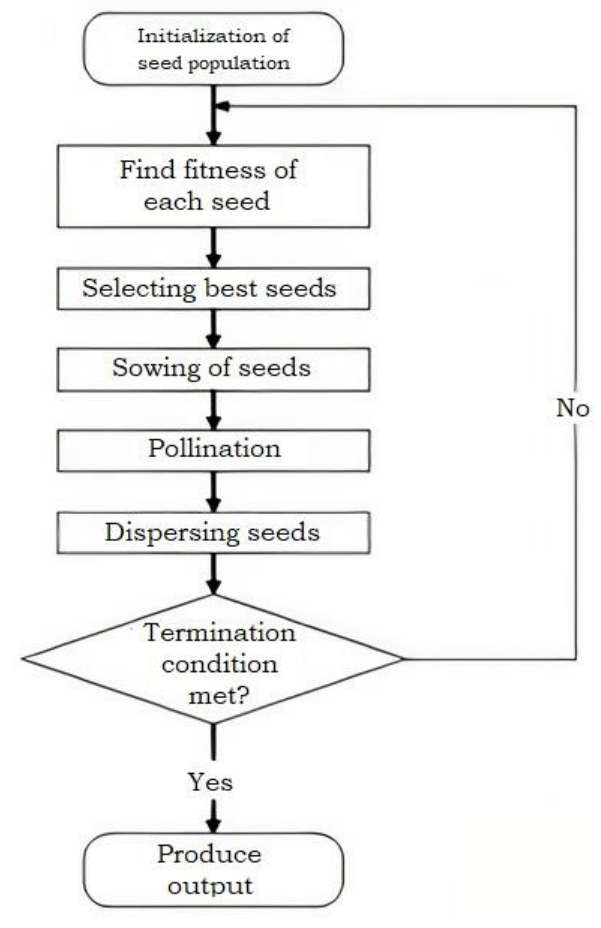
Figure 1. The complete process followed in the paddy field algorithm